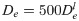
Simulation results for platelet aggregation at high shear rates with occlusion levels of 20–60% corresponding to the undisturbed maximum wall shear rates 2,000 − 6,000 s−1.A fixed value (De=500Del) for platelet’s adhesive forces is used (a-d); shear-dependent correlation in Eq (10) is used (e-h). (a), (b) and (c) Snapshots of platelet aggregation inside 60, 40 and 20% stenoses, respectively. (e), (f) and (g) Snapshots of platelet aggregation inside 60, 40 and 20% stenoses, respectively. No aggregation is found for 20% stenosis; (d) and (h) density of adhered platelets inside the stenosis vs. simulation time. Color coding for particles is the same as in Fig 3. Here, the activation delay time is τact = 0s.